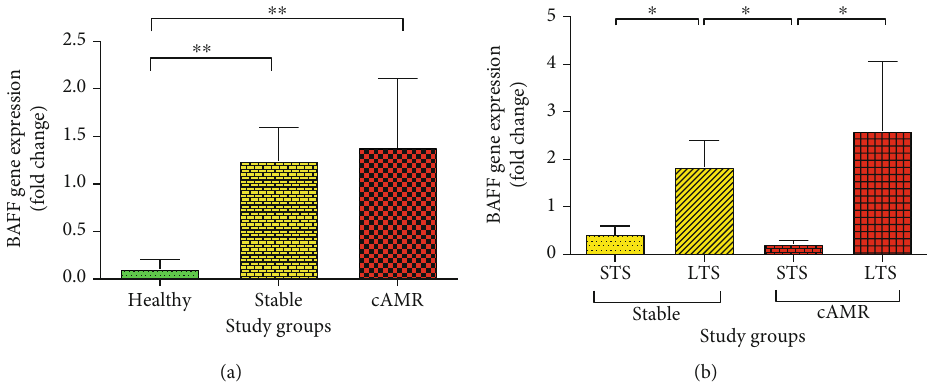
Figure 6: BAFF mRNA expression level in healthy individuals, patients with stable graft function, and cAMR patients (a). BAFF mRNA expression level in stable and cAMR patients with short-term survival (STS) and long-term survival (LTS) (b). Error bars represent SEM ( ∗ P ≤ 0 : 05 , ∗∗ P ≤ 0 : 01 ).